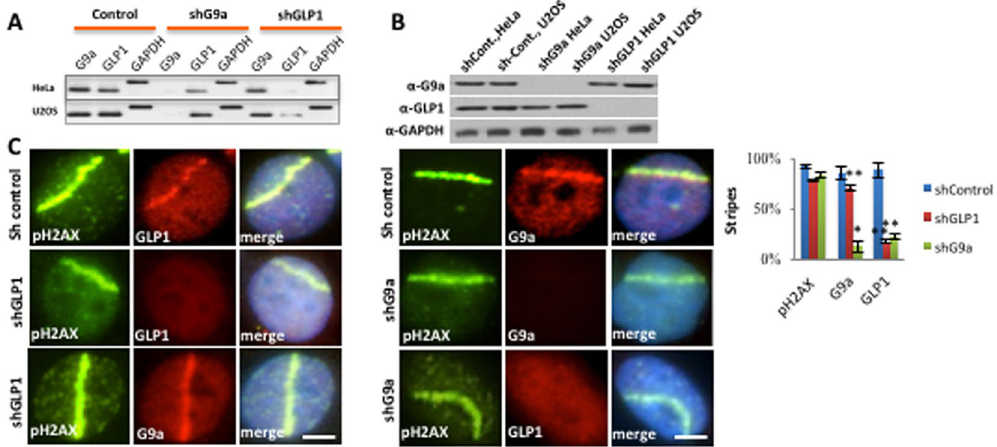
Figure 2. G9a is required for GLP localization to DNA breaks. ( A ) Total RNA was extracted from Hela and U2OS cells expressing control, G9a or GLP1 shRNAs and subjected to RT-PCR using primers for G9a, GLP1, and GAPDH. ( B ) Western blots of HeLa and U2OS cells treated as above, probed with indicated antibodies. ( C ) U2OS cells expressing control shRNA, GLP1 shRNA (Left panels) or G9a shRNA (right panels) were laser micro-irradiated and analyzed by IF as indicated. Quantifications of results are plotted on right. Each point is the mean of at least three experiments ± the SEM. ** P < 0.01, * P < 0.05. Scale bar, 5 μ